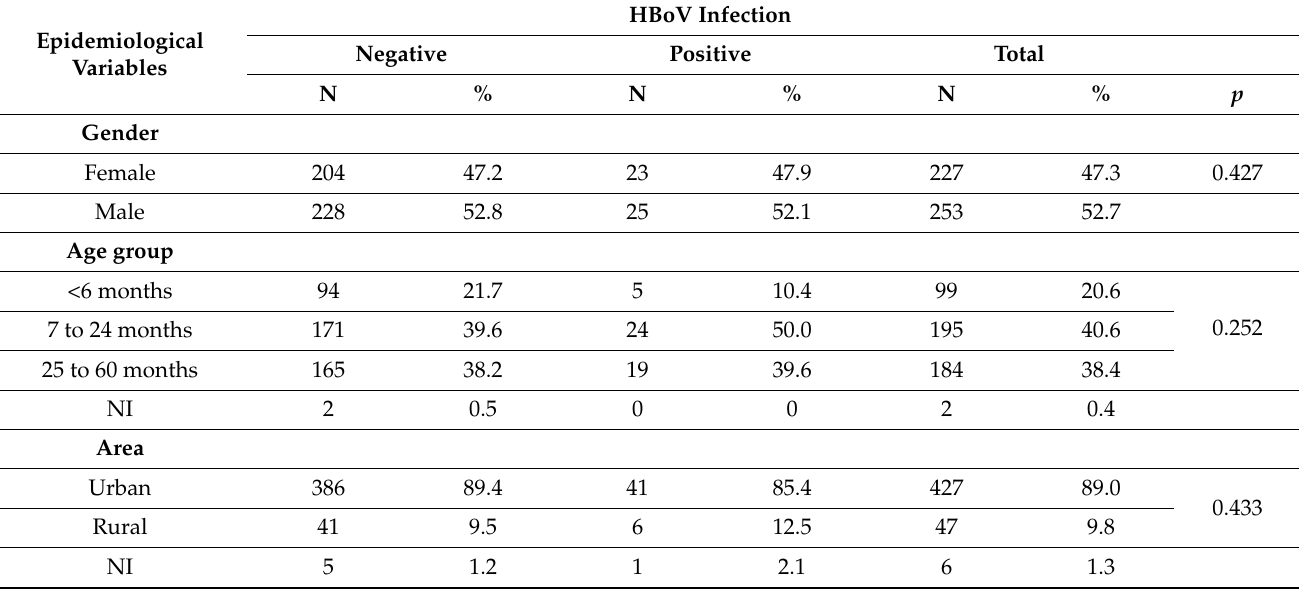
Table 1. The association between epidemiological aspects and HBoV infection in children from Acre State,